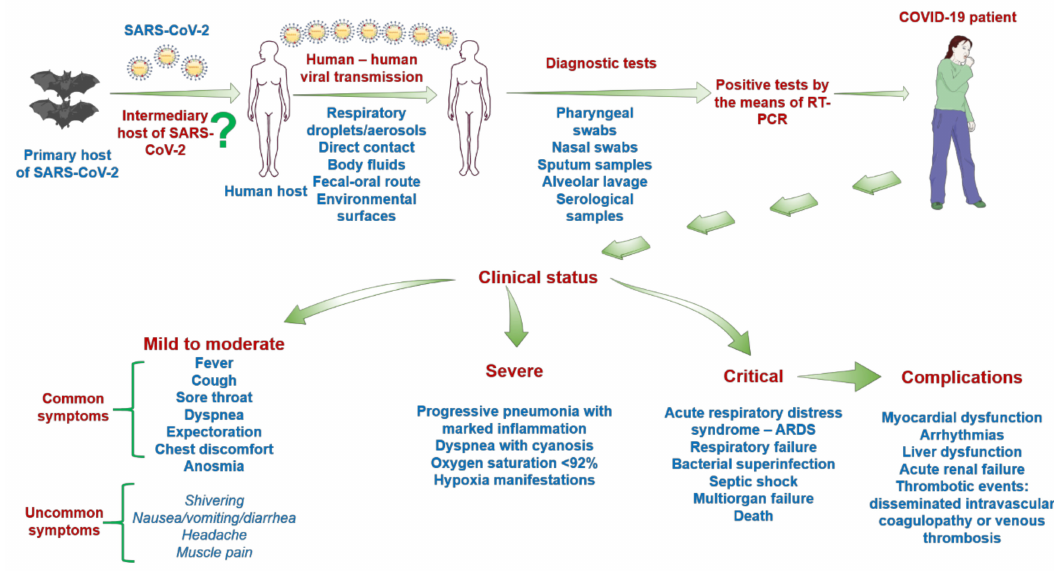
Figure 4. Schematic overview of the steps involved in SARS-CoV-2 infection from the first contact with the virus until the final phase—death or recovery. This image contains Servier Medical Art elements, which are licensed under a Creative Commons Attribution 3.0 Unported License; https: //